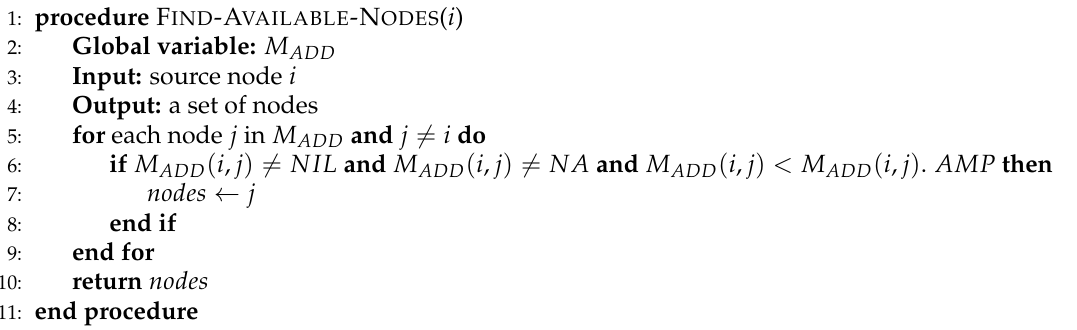
Algorithm 1 Find nodes that are available to transmit electrical energy for the node i . The node j is available for the node i , only if i and j are connected; and there are no energy flows from j to i ; and the arc ( i , j ) has sufficient energy capacity.